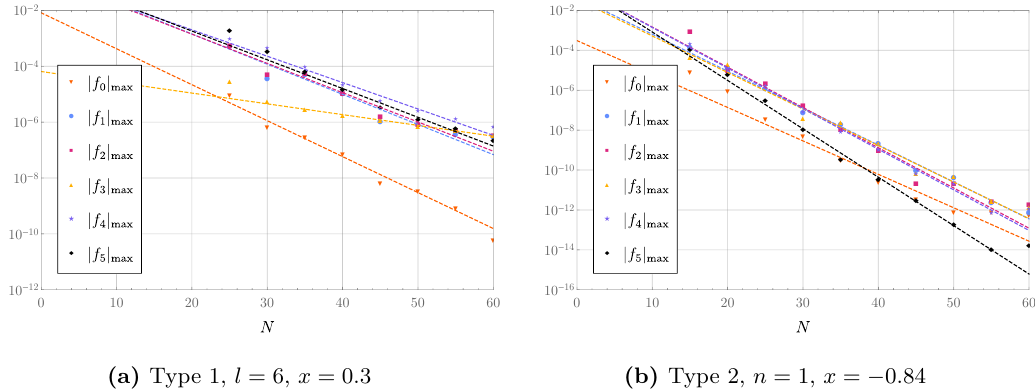
Figure 11 . The maximum absolute values of the functions f 0 , f 1 , f 2 , f 3 , and f 4 at the grid points r = 0 , and of f 5 at the grid points θ = 0 . Figure (a) shows the Type 1 deformation (2.5) with l = 6 and x = 0 . 3 , while figure (b) shows the Type 2 deformation (2.7) with n = 1 and x = − 0 . 84 . Note that | f i | max vanishes with increasing numerical resolution, indicating convergence to a smooth bulk solution.